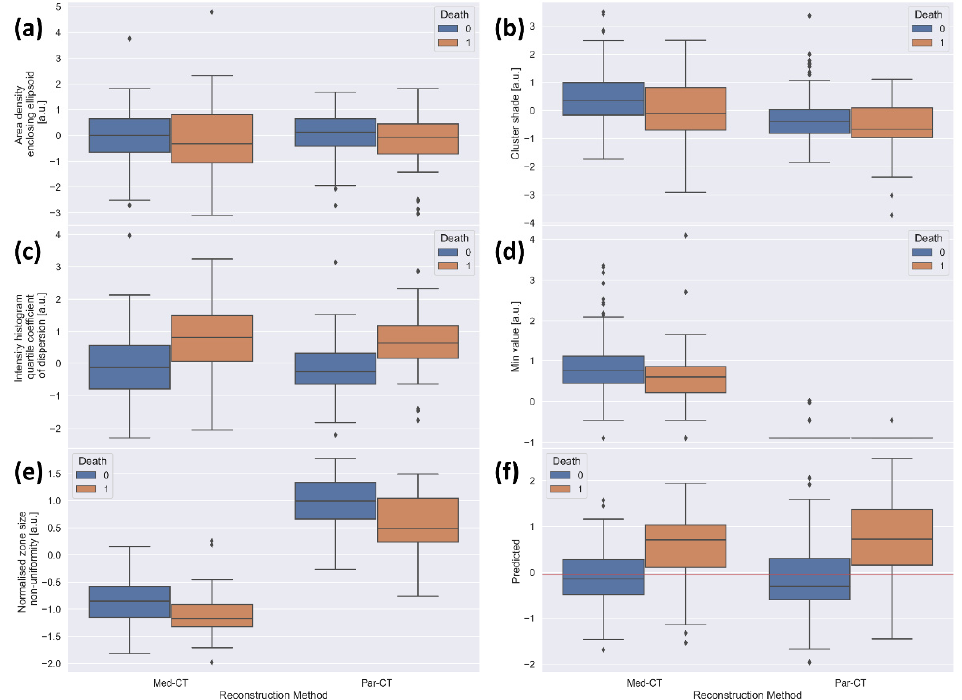
Figure 5. Boxplots of the standardized values of the features included in the final model for the 196 patients used as validation, divided by reconstruction type (left side of each plot: Med-CT, right side of each plot: Par-CT) and by final outcome (blue: alive, orange: death). The plots are relative to ( a ) area density aligned ellipsoid, ( b ) cluster shade, ( c ) intensity histogram quartile coefficient of dispersion, ( d ) min value, ( e ) normalized size non-uniformity, and ( f ) value predicted by the model in the validation datasets. The red horizontal line corresponds to the median obtained using the training dataset.